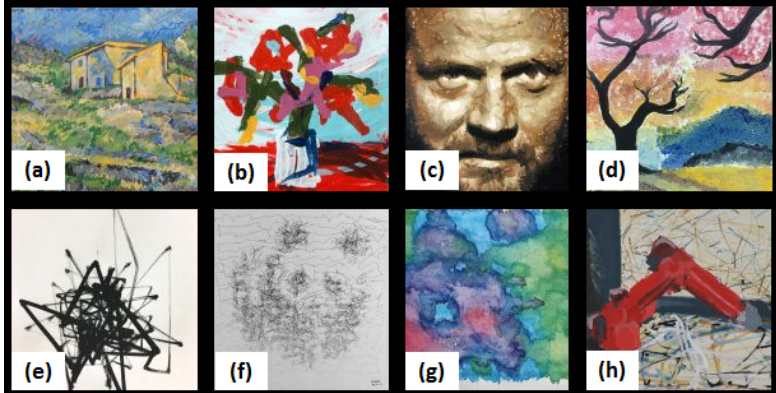
Figure 2. Examples of paintings from the robot art competition: ( a ) Cezanne’s Houses at L’Estaque by CloudPainter; ( b ) Red Flowers (Floral no. 1) by Joanne Hastie; ( c ) Man by PIX 18 at Columbia University; ( d ) Full Bloom of Sakura by CMIT ReART at Kasetsart University; ( e ) Scribbles by CARP at Worcester Polytechnic Institute; ( f ) WWF by JACKbDU at New York University Shanghai; ( g ) Perlin Noise Field by Late Night Projects; and ( h ) Homage To Jackson Pollock by e-David at University of